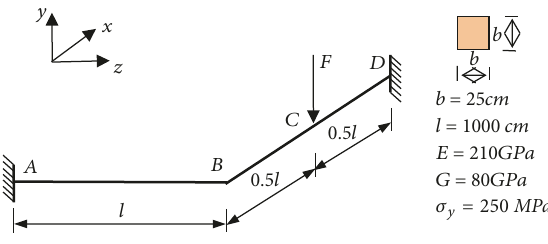
Figure 18: Spatial right angle